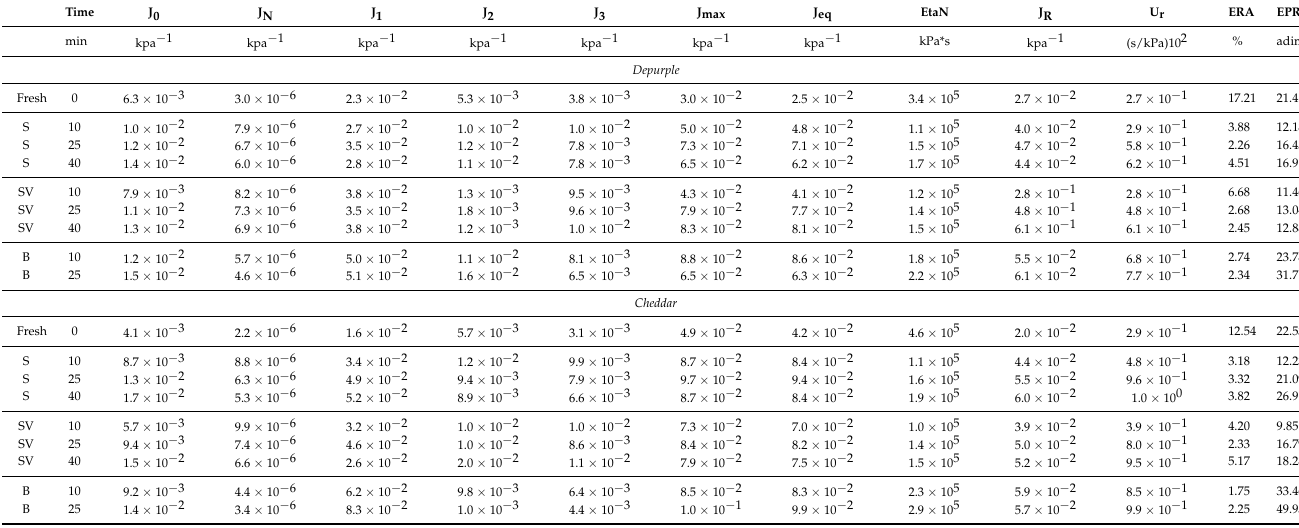
Table 1. Impact of the boiling (B), steaming (S) and sous-vide (SV) on the rheological properties on a microscopic scale as described by the parameters obtained from the tailored Burger’s model for Depurple (top) and Cheddar (bottom) cauliflower.